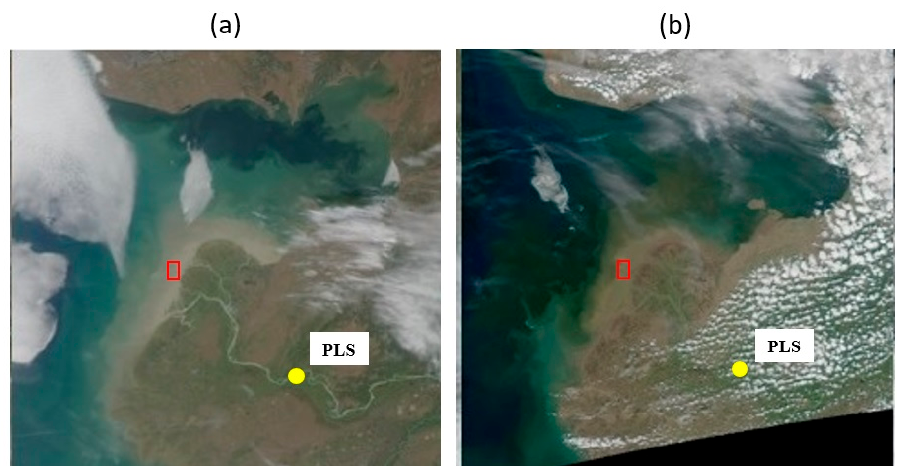
Figure 10. RGB (Red-Green-Blue color model) composite images of MODIS/Aqua on ( a ) 4 September 2009 and ( b ) 22 June 2010. The red rectangles show the area of the coastal observations on 6 September 2009 and 22 June 2010. The label “PLS” shows the location of the USGS gauging station at the Pilot Station village.